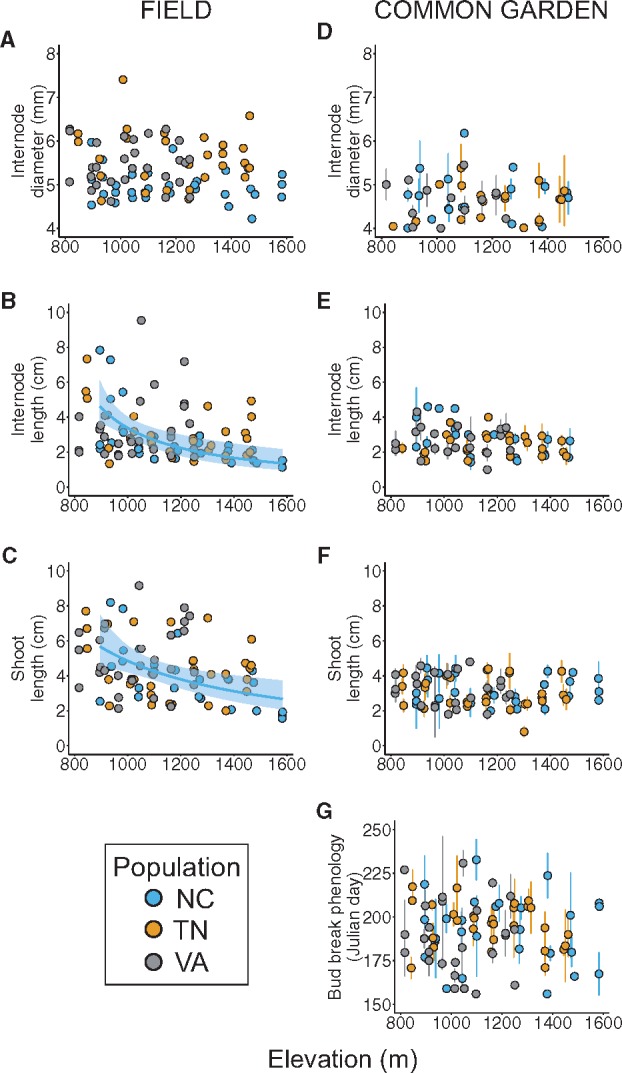
The effect of elevation on traits related to growth and timing (internode diameter, internode length, shoot length, leaf bud break phenology) in Rhododendron maximum measured at the individual level in natural field populations along three elevation gradients (A-C; bud break phenology was not measured in the field) and the effect of source elevation on mean ± SE trait values measured at the replicated cutting level in a common garden (D-G). Populations are represented by each of three colours (North Carolina [NC], blue; Tennessee [TN], orange; Virginia [VA], grey). A solid black line indications a significant (P < 0.05) effect of elevation across populations (no population-by-elevation interaction). When statistical models detected significant or marginally significant population-by-elevation interactions, coloured regression lines corresponding only to those populations in which traits varied significantly (P < 0.05) along elevation are shown. The shaded region around each line represents the 95 % confidence interval for that regression.